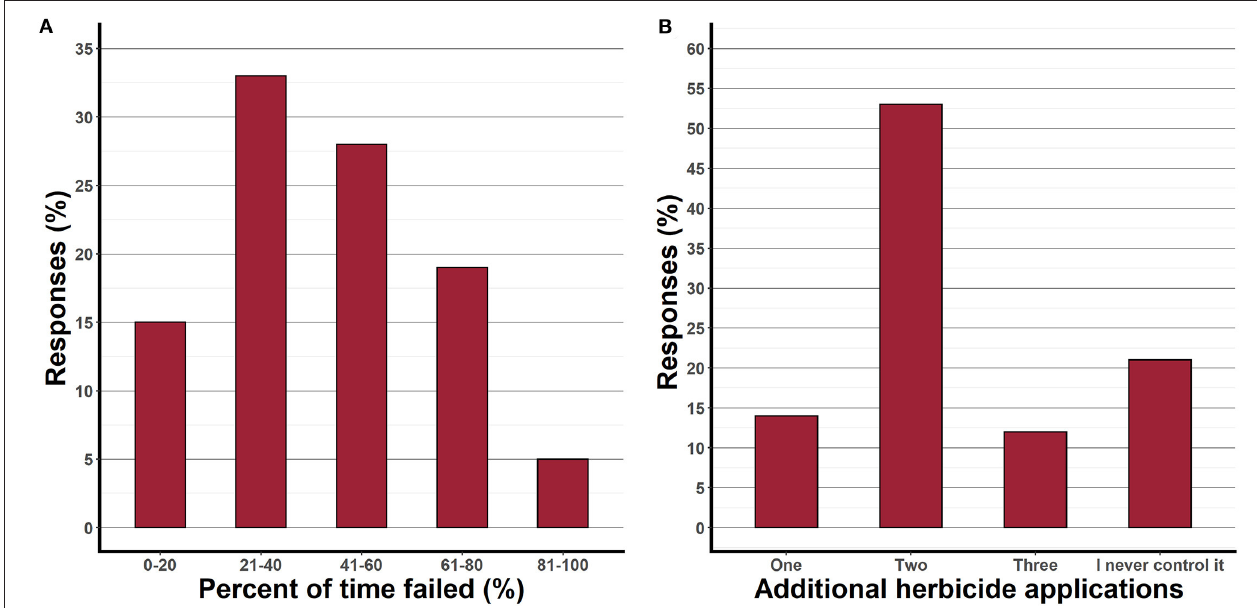
FIGURE 5 | Responses for (A) percent of the time that respondents failed to effectively control Echinochloa crus-galli (L.) P. Beauv. with the first postemergence herbicide application ( n = 100) and (B) the average number of additional applications required for Echinochloa crus-galli (L.) P. Beauv. control if the initial application fails ( n = 81).